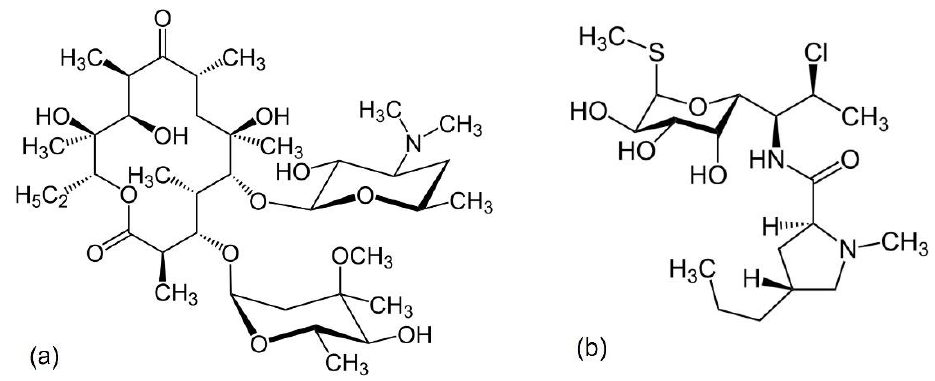
Figure 10. Generic structures of ( a ) macrolides and ( b ) lincosamides.